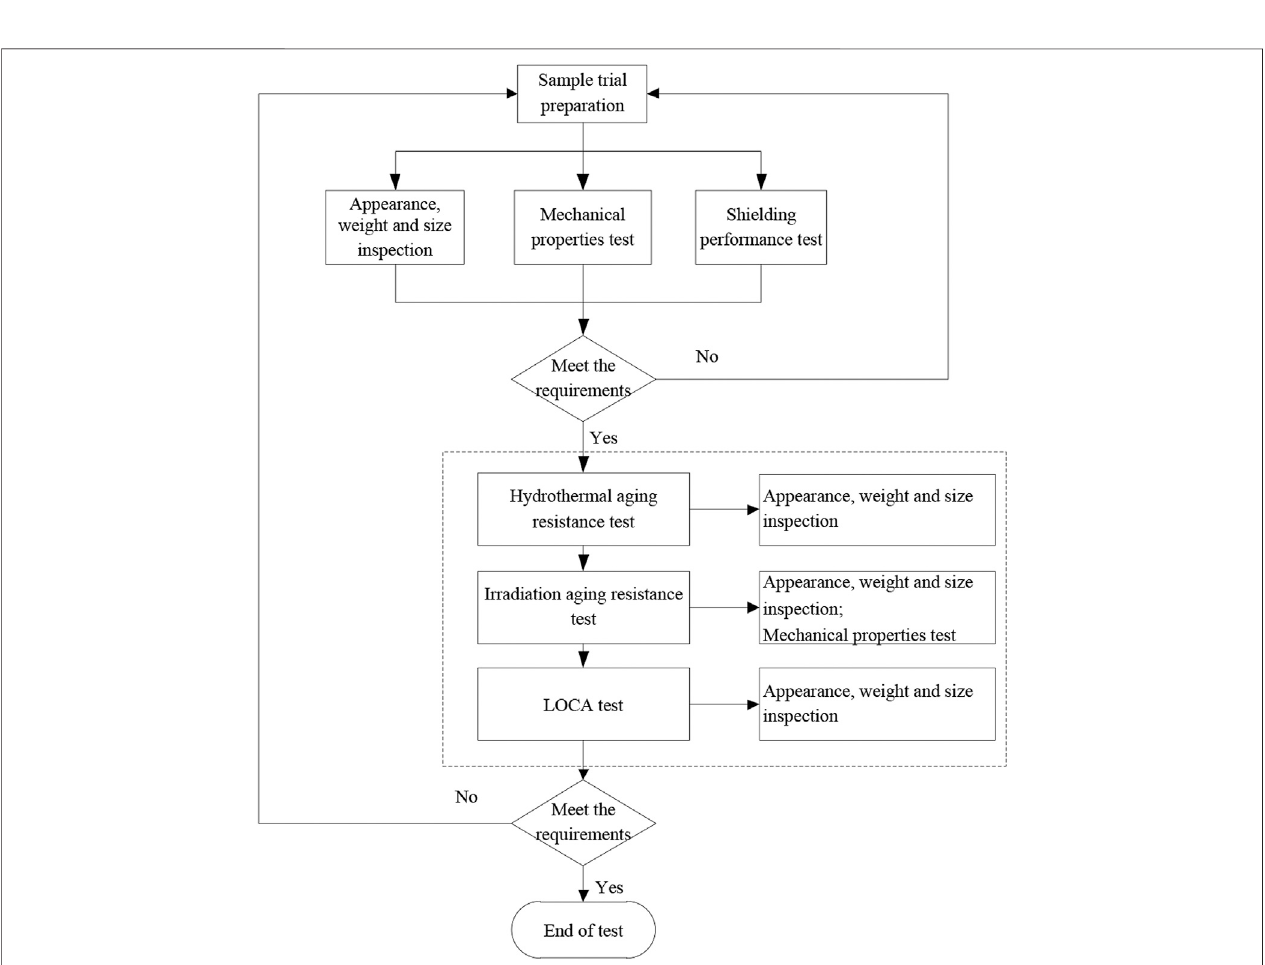
FIGURE 2 | Test scheme fl ow